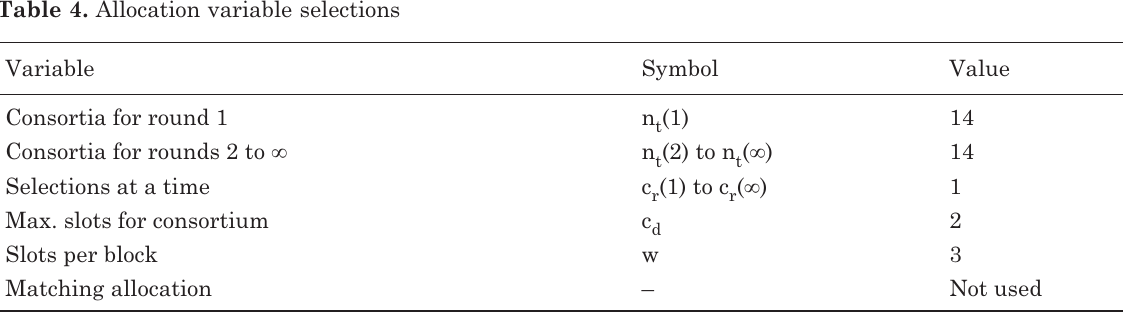
Table 4. Allocation variable